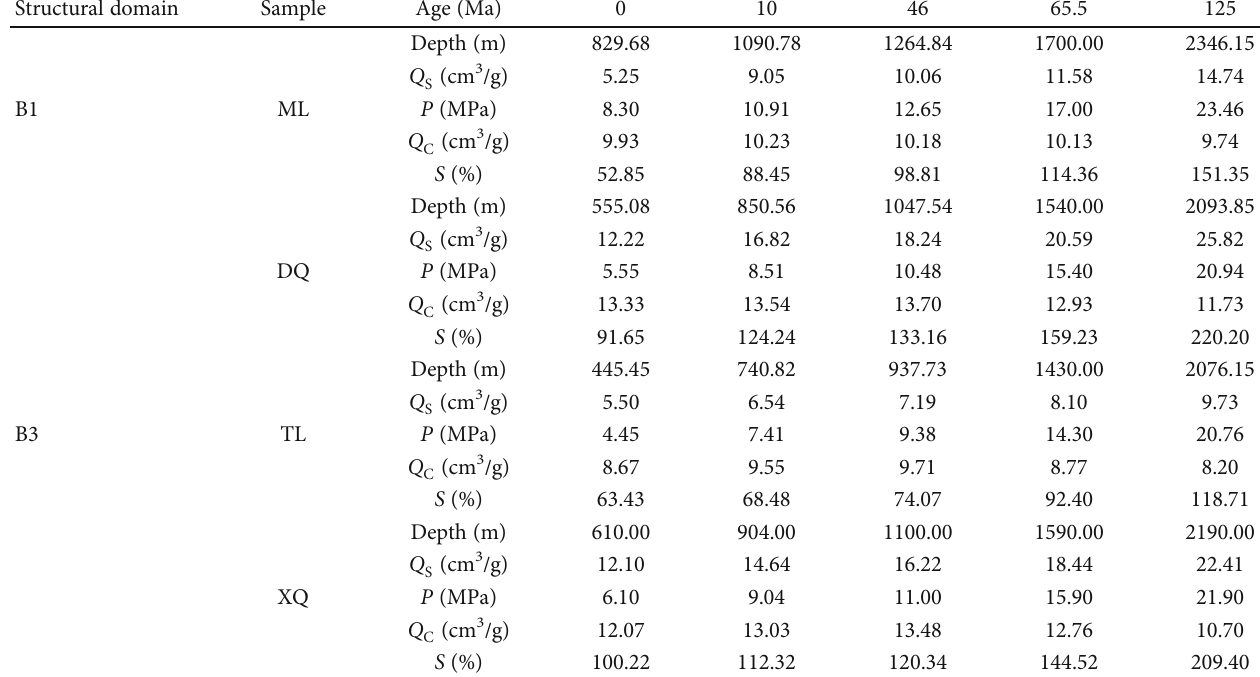
Table 3: The sorption capacity, gas content, and saturation evolution characteristics of the sampling sites after thermal metamorphism processes. Structural domain